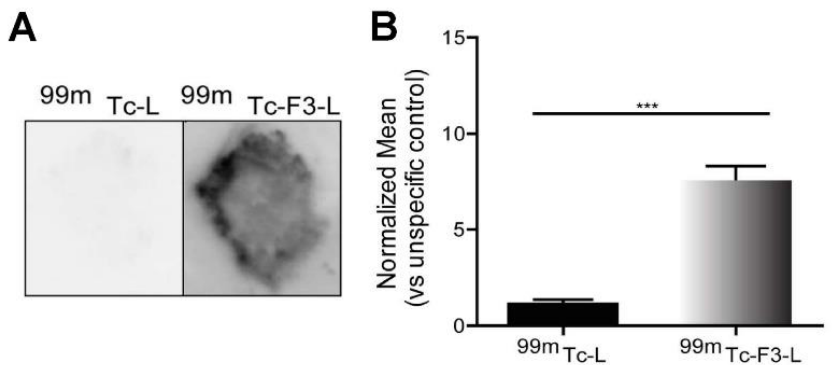
Figure 3. Ex vivo cellular association of radiolabeled nucleolin-binding F3-peptide-targeted liposomes to sections of patient-derived pulmonary carcinomas. Tumor sections were incubated for 1 h at room temperature with technetium-99m-labelled liposomes, either targeted with nucleolin-binding F3 peptide ( 99m Tc-F3-L) or non-targeted ( 99m Tc- L). ( A ) Representative autoradiograph images of bound liposomes to human pulmonary carcinomas and ( B ) the extent of binding is presented. Data represent the mean ± SEM, bars (n = 7), and were analyzed by two-tailed unpaired t -test (*** p < 0.001).